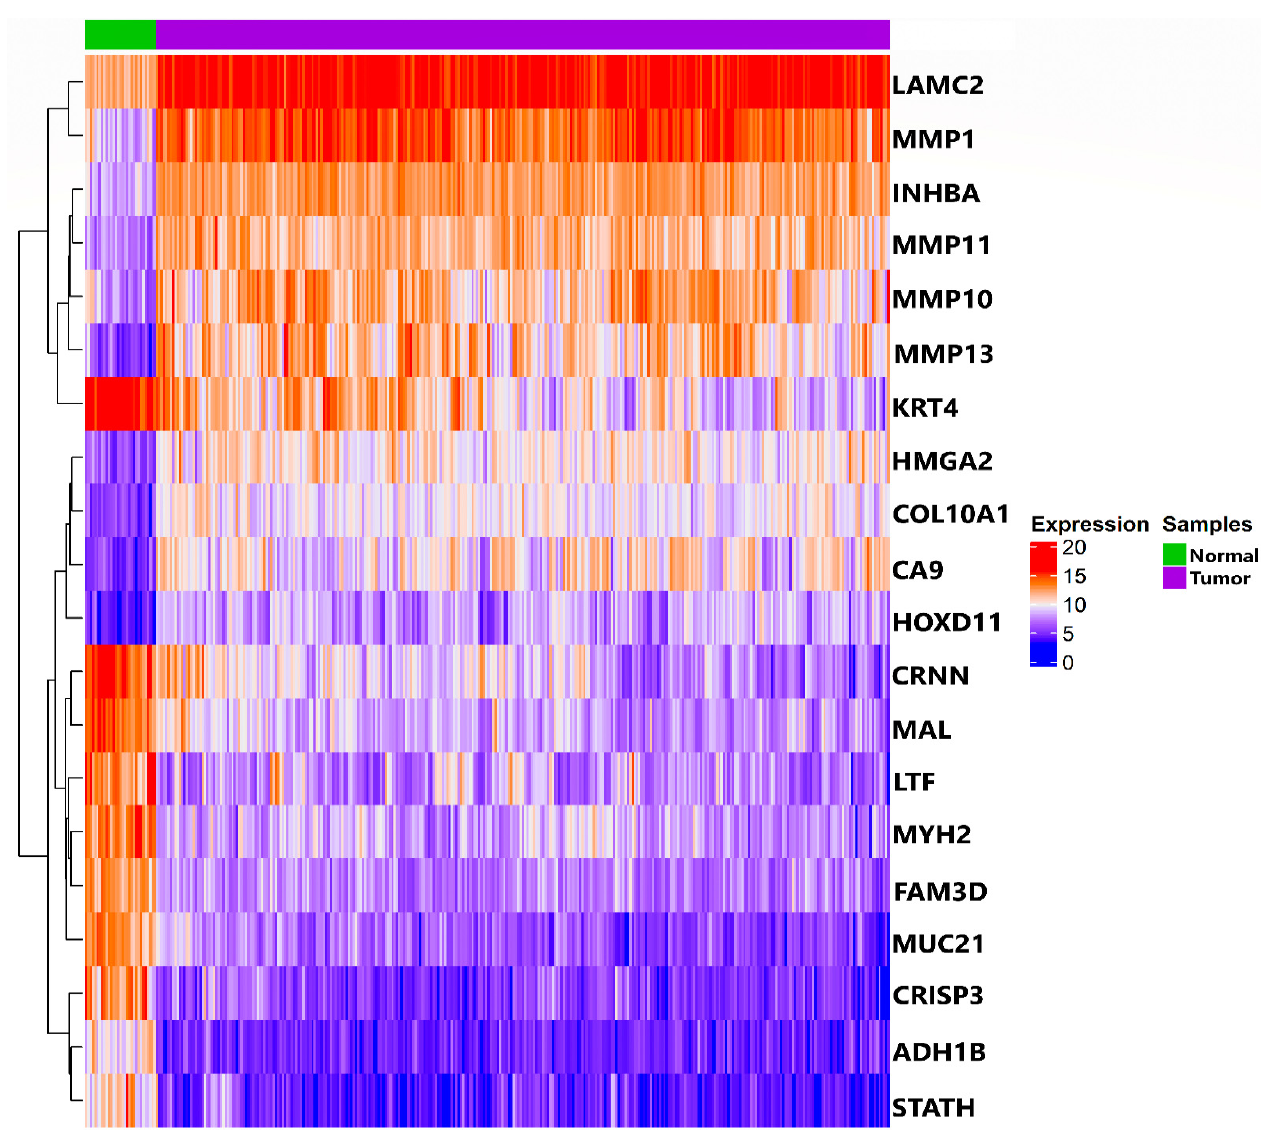
Figure 2. Heatmap of the top 10 up and downregulated OSCC-associated DEGs. Hierarchical clustering using Pearson distance was applied for rows with its corresponding cluster dendrogram being displayed along the left side of the plot, respectively. The column annotation bar depicting status of samples (i.e., green for normal and magenta for tumor) was shown at the top of the heatmap.